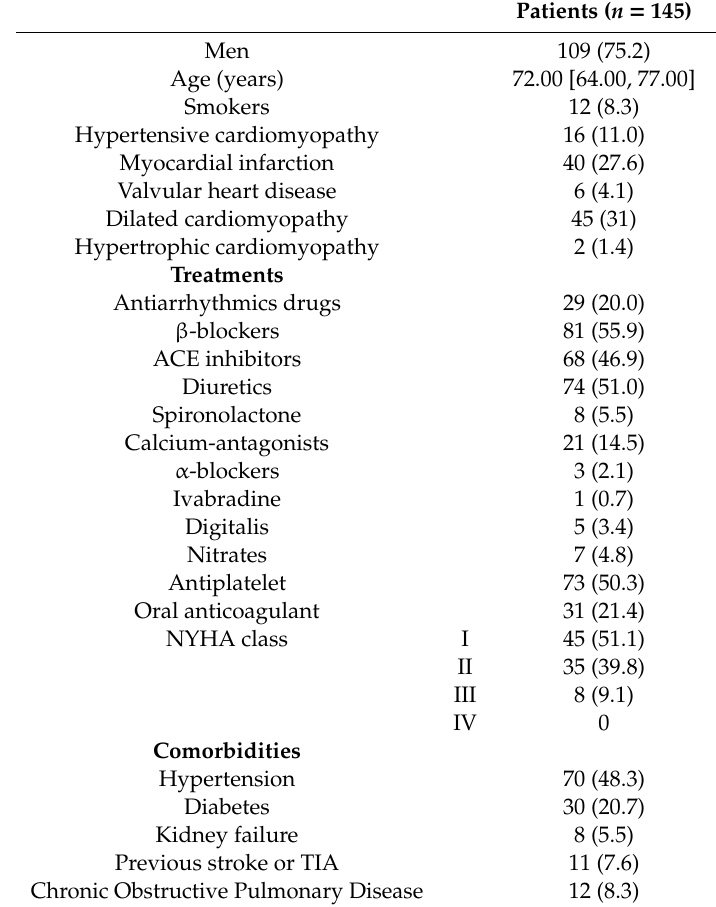
Table 1. Baseline patient characteristics.